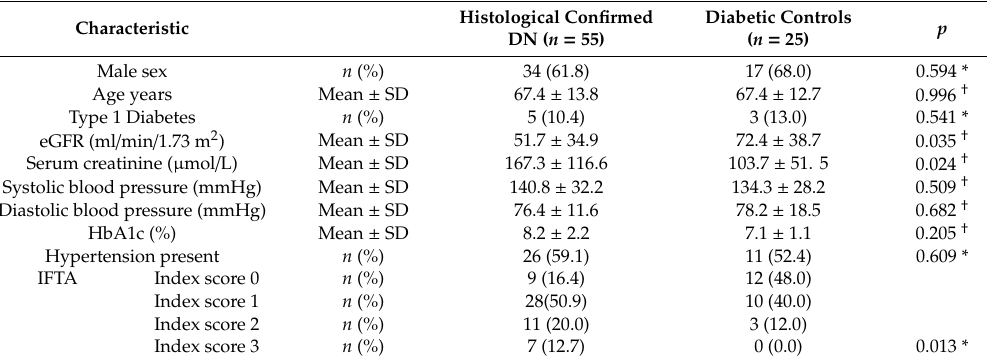
Table 1. Baseline characteristics of